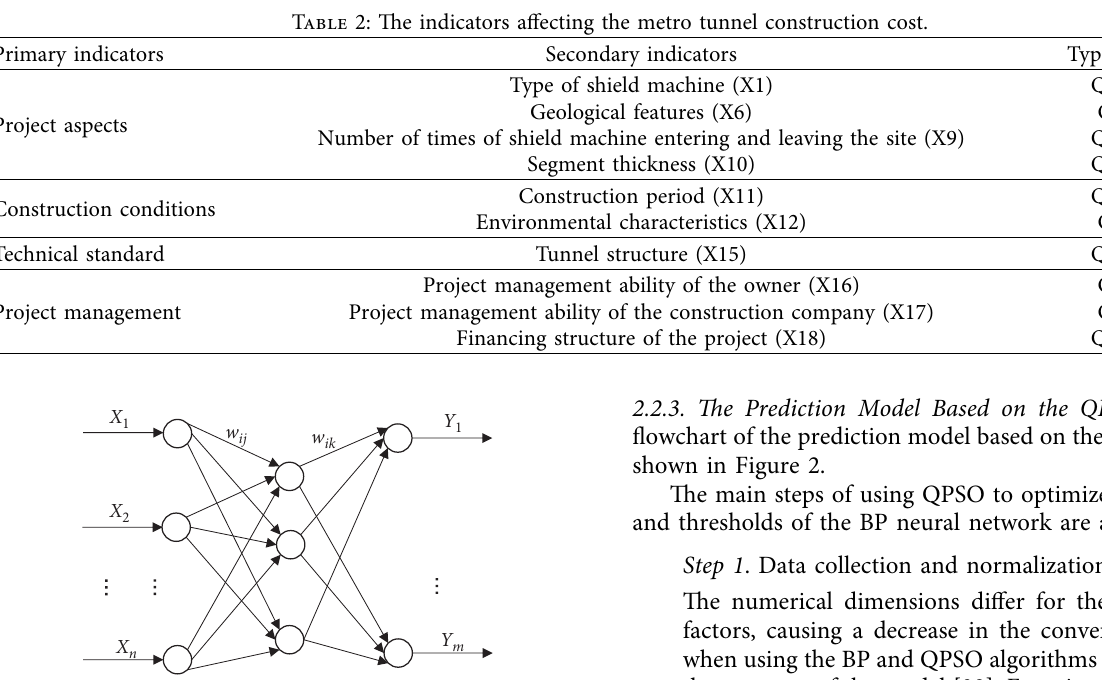
Figure 1: The structure diagram of the BP neural network.